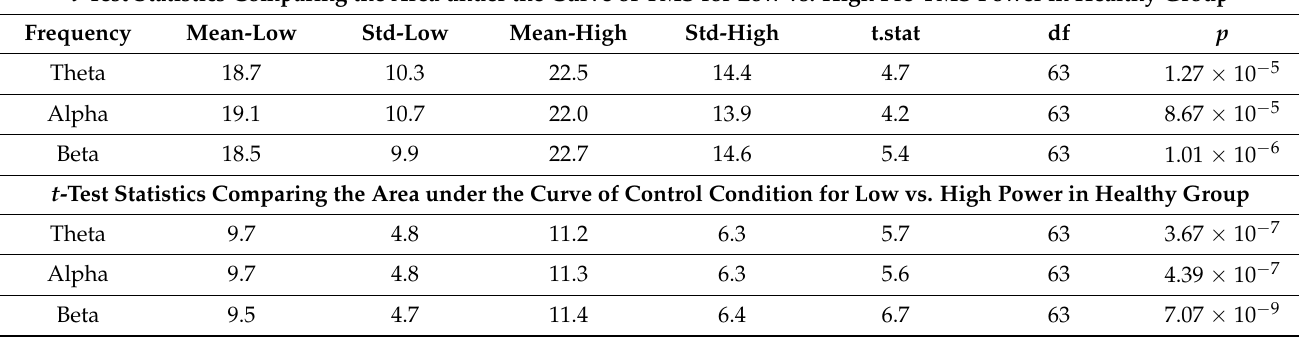
Table 3. Student’s t -test results of comparing the area under the curve (AUC (TMS) or AUC (Control) ) based on the pre-stimulus power (low power vs. high power) over theta, alpha, and beta frequency bands. Significance level ( p ) was adjusted for multiple comparison as 0.008 (0.05/6). Std = standard deviation, low power = below the median, high power = above the median, df = degree of